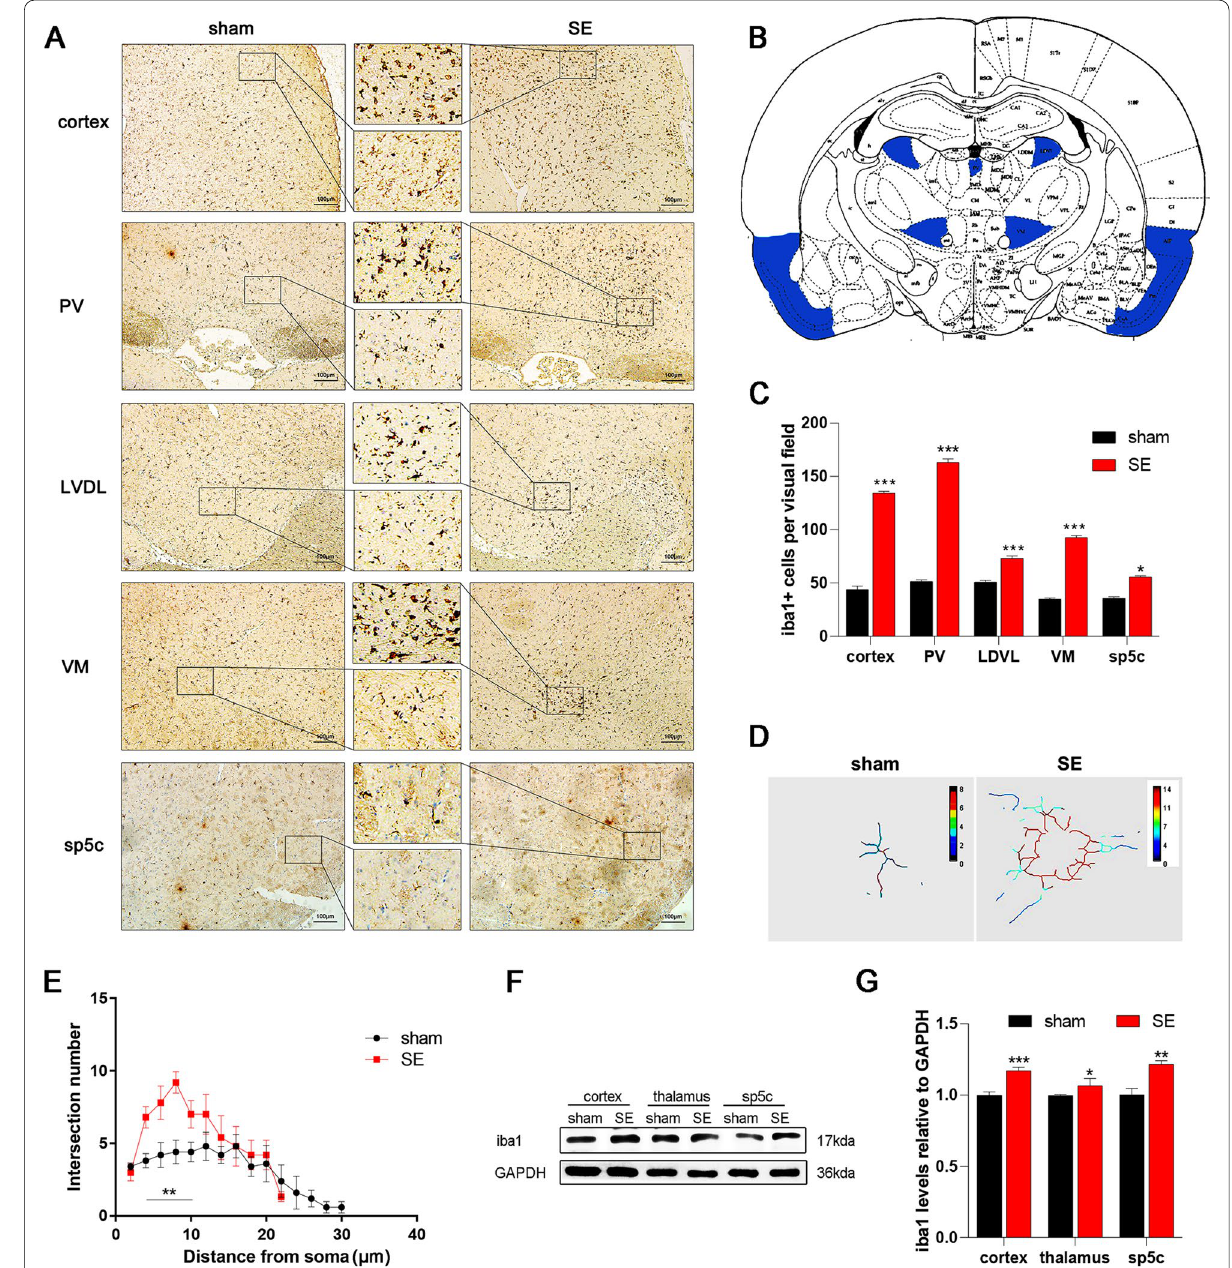
Fig. 2 SE-induced increase in microglial activation and number in the cortex/thalamus/sp5c in adult rats. A Representative immunohistochemical staining of iba1 in the cortex, PV, LDVL, VM, and sp5c. Scale bars 100 μm. B Iba1-positive (iba1 ) areas in different brain regions. C Quantification = + of the number of Iba1 cells. Mean SEM; unpaired t test versus sham group; n 3 rats per group. * P < 0.05, *** P < 0.001 compared to the sham + ± = group. D‑E Sholl analysis of microglia showed that SE-induced branch shortening and increased synapses compared to those in the sham group. Mean SEM; unpaired t test versus sham group; n 6–11 cells per group; ** P < 0.01. F Western blot analysis of iba1 in the cortex, thalamus, and ± = sp5c. G Western blot showing that the protein levels of iba1 in the cortex/-thalamus/sp5c were increased compared those in to the sham group. n 3 rats per group. Mean SEM; unpaired t test versus sham group; * P < 0.05, ** P < 0.01, *** P < 0.001 compared to the sham = ±